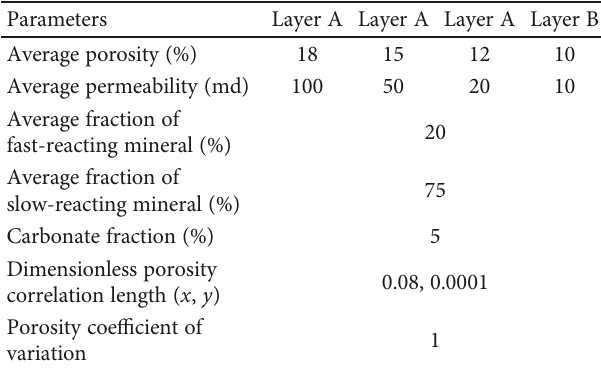
Figure 10: Silica precipitation distribution after acidizing for homogeneous and heterogeneous initial Table 3: Parameters for layers A and B.